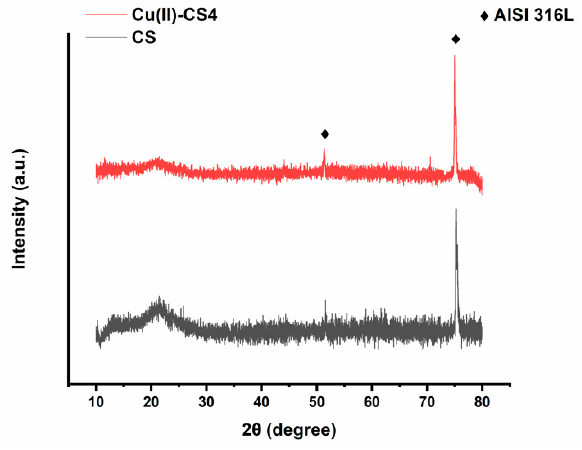
Figure 4. X-ray di ff raction (XRD) patterns of CS and Cu(II)–CS4 Figure 4. X-ray diffraction (XRD) patterns of CS and Cu(II)–CS4 coatings.